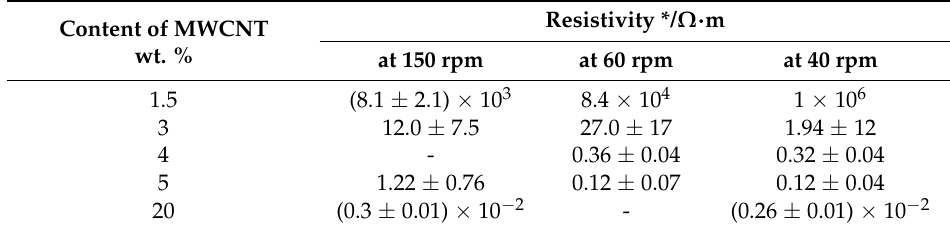
Table 1. Electrical resistivity of low density polyethylene/multi-walled carbon nanotubes (LDPE/MWCNTs) nanocomposites fabricated at different speeds of the extruder’s screw (rpm). Content of